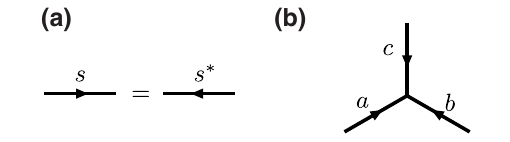
FIG. 11. (a) Inverting a string s is the same as changing to the dual string s ∗ . (b) The orientation convention for branching at a